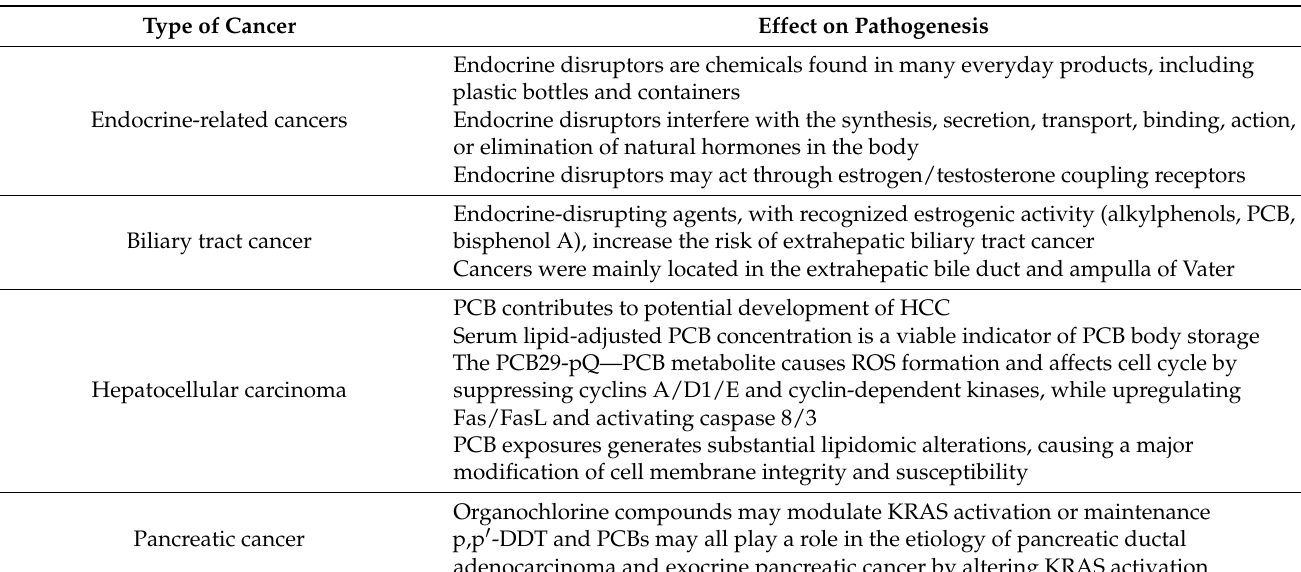
Table 1. Effect of plastic-related compounds on cancer